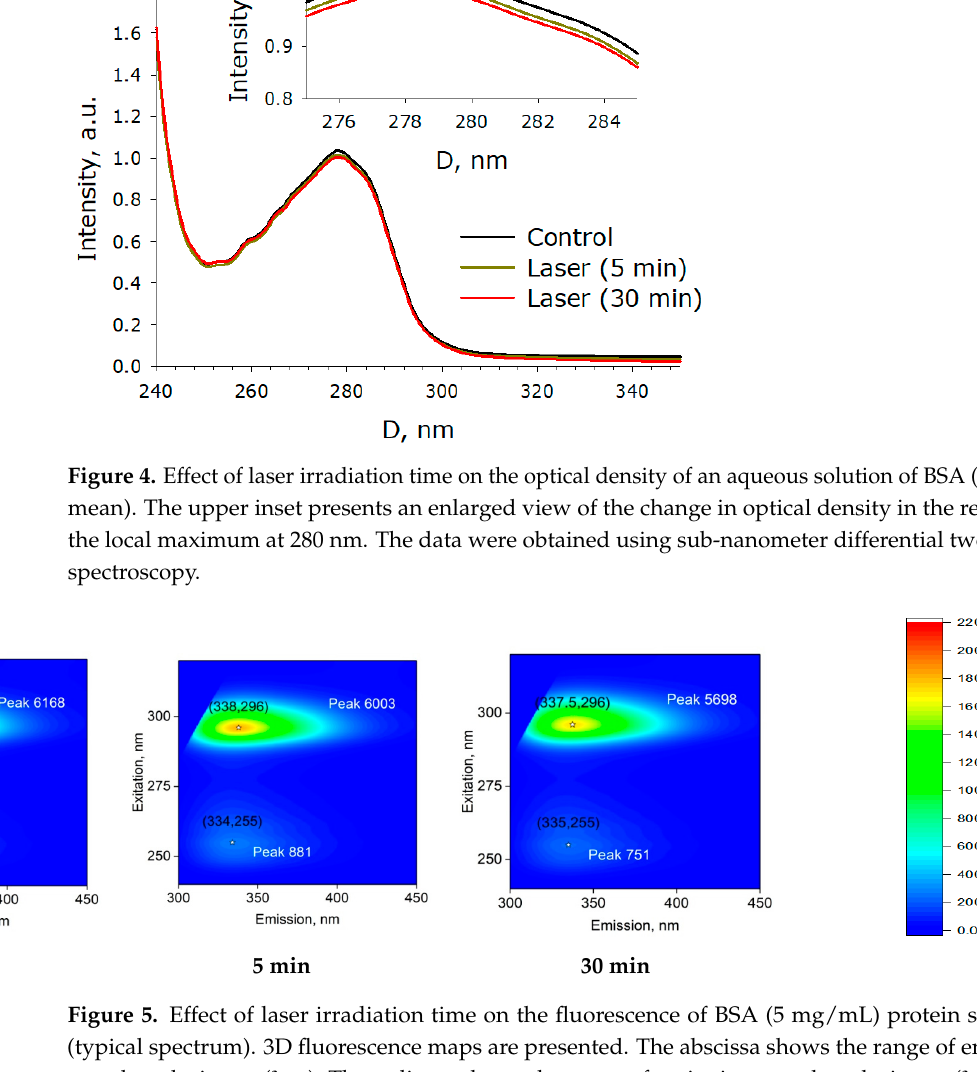
Figure 6. Raman spectra of BSA solutions for control and after 30 min laser exposure. The data were obtained with a Raman microscope. The intensity along the y-axis is presented in relative units. The effect of laser irradiation time on the refractive index of the BSA solution at wavelengths of 435.8 nm, 589.3 nm, and 632.8 nm was studied (Figure 7). It was shown that the BSA refractive index does not change significantly after exposure to laser radia- tion at all investigated wavelengths.